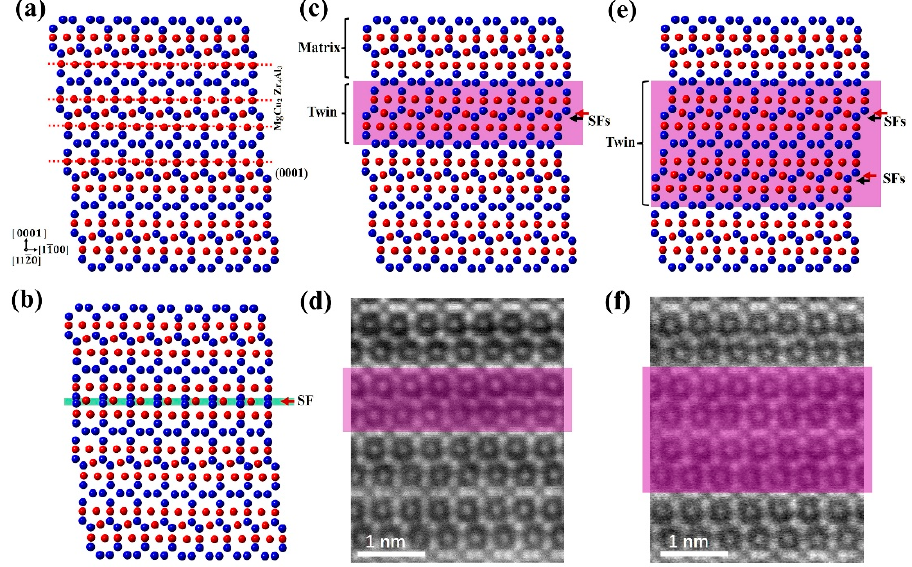
Figure 4. ( a ) The atomic arrangement of a perfect crystal lattice of the μ phase, showing alternating stacking of Zr 4 Al 3 and MgCu 2 units along [1120] µ ZA, ( b ) one stacking fault (SF, red spheres) on (0001) planes in MgCu 2 -type unit of the μ phase, and the red arrow means the slip direction of the partial dislocation and a layer SF, ( c , d ) atomic arrangement diagram and STEM image of (0001) twins in the μ phase, and ( e , f ) atomic arrangement diagram and STEM image of the growth of (0001) twins. Red-colored spheres mean Fe/Ni atoms, and blue-colored spheres mean W/Mo atoms.